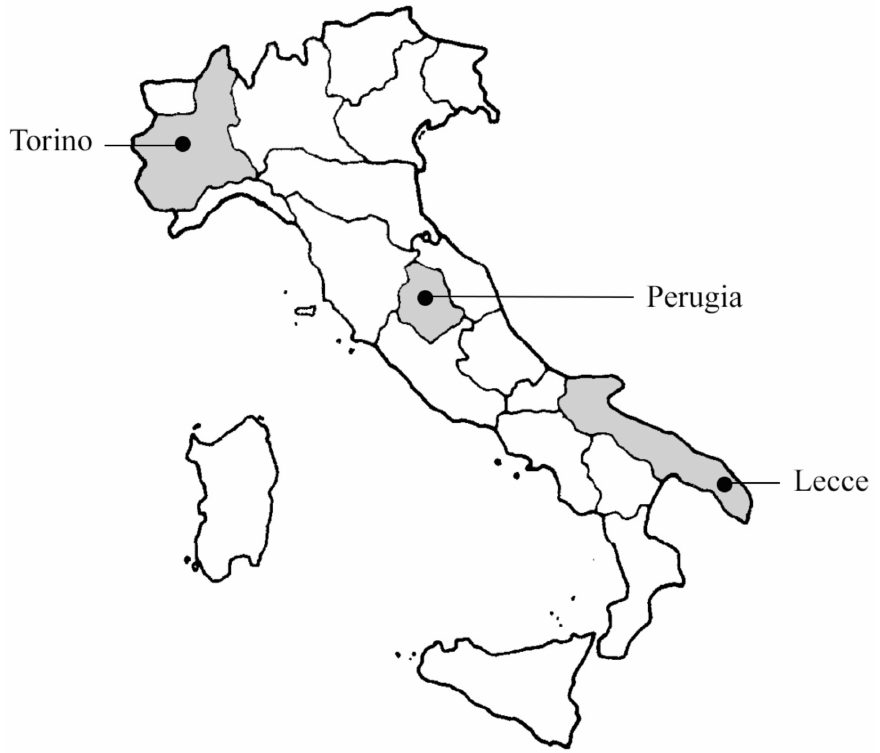
Figure 1. Location of the three cities involved in the